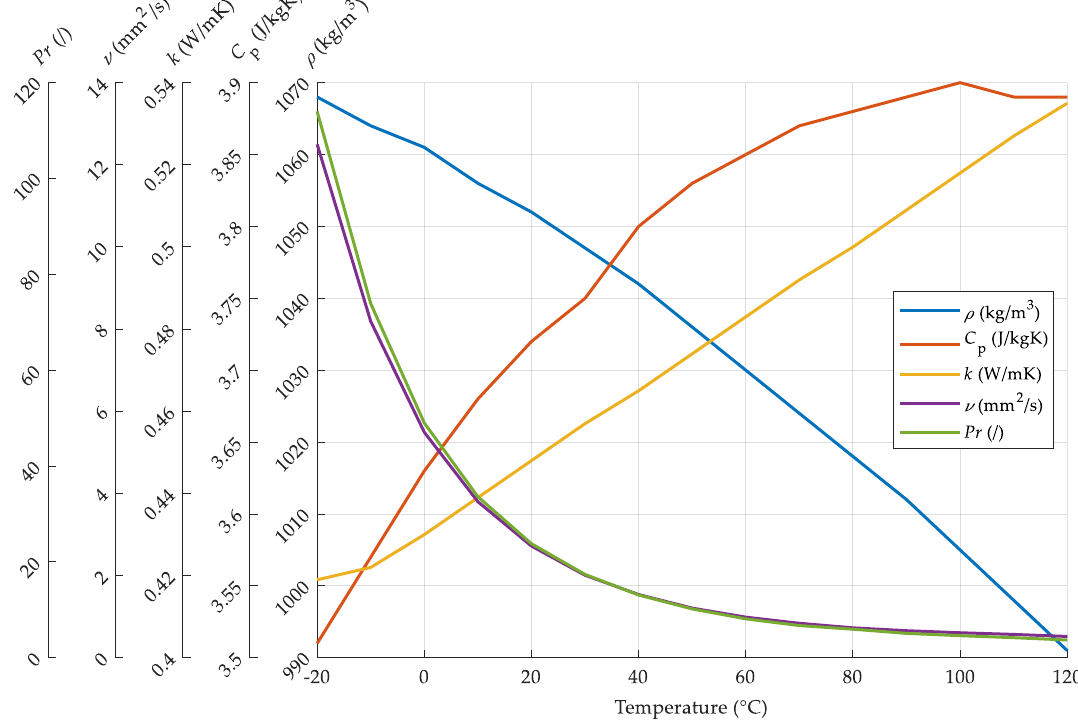
Figure 8. Thermal properties of the working medium as a function of temperature [summarized by 64].